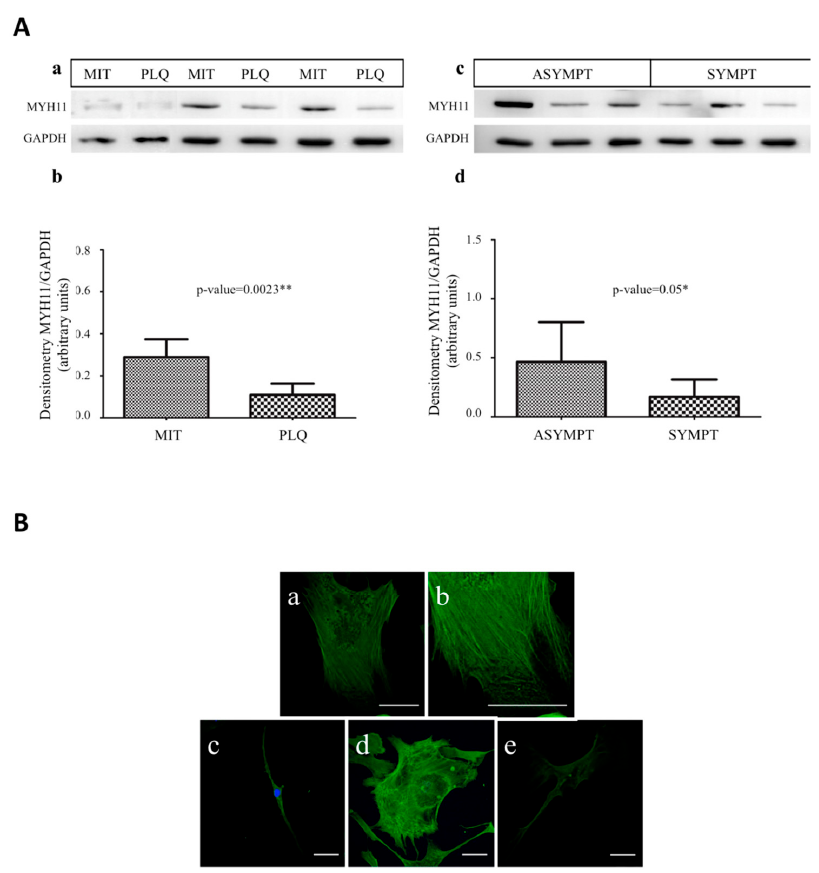
Figure 4. ( A ) MYH11 protein expression in carotid atherosclerotic VSMCs. ( a , b ) Western Blot of MYH11 protein in plaque or adjacent MIT area VSMCs, and asymptomatic or symptomatic plaque VSMCs, respectively; ( c , d ) graphic representation of A and B show the average of densitometry values of the bands respect to GAPDH protein expression. (MIT: macroscopically intact tissue area VSMCs; PLQ: plaque VSMCs; ASYMPT: VSMCs from asymptomatic plaques; SYMPT: VSMCs from symptomatic plaques) ( p < 0.05 * and p < 0.01 ** were considered statistically significant); ( B ) Immunofluorescence of carotid atherosclerotic VSMCs with MYH11 and nuclei staining. ( a ) MIT-VSMC myofilaments extend throughout the cell forming a network with weaker MYH11 staining in the cell periphery; ( b ) with 2.00 zoom focusing on the cell periphery where MYH11 staining appears as spots; ( c , d ) show MYH11 staining in MIT-VSMCs (c image shows elongated and spindle-shaped cell; and d, flattened and polarized cell with lamellipodia); ( e ) PLQ-VSMCs present low fluorescence intensity of MYH11 protein and appear forming thin myofilaments. Scale bar 50 µ from Asymptomatic and Symptomatic Patients or between PLQ and MIT Area analyzed metalloproteinase 3, 7, 9 and metalloproteinase inhibitor 1 expression levels in our VSMC samples (symptomatic/asymptomatic and PLQ/MIT) (Figure S3A and S3B). No significant